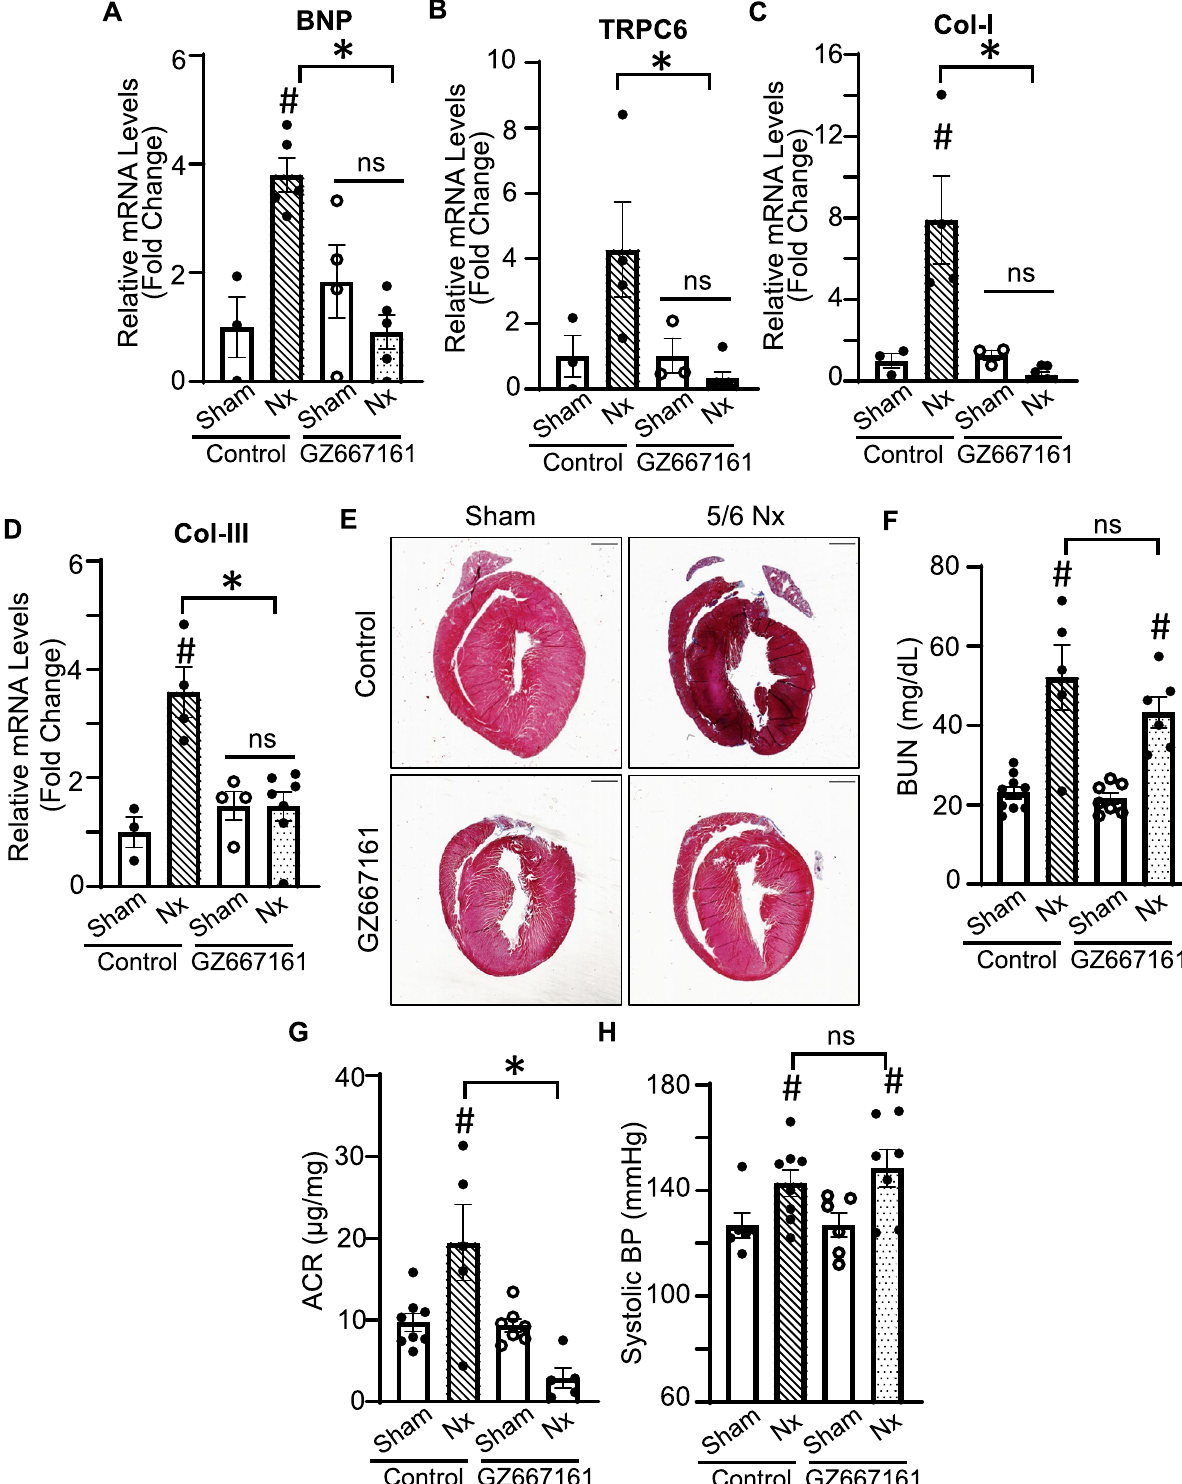
Figure 8. GZ667161 ameliorates expression of cardiac remodeling genes in CKD mice. ( A – D ) RNA from heart tissue was isolated and RT-qPCR was performed to examine the expression of cardiac remodeling genes in the heart in mice with 7 weeks post-5/6 Nx operation. ( A ) BNP. ( B ) TRPC6. ( C ) Col-I. ( D ) Col-III. ( E ) Representative trichrome staining of CKD hearts. Scale bar is 1 mm. Sham (n = 3–4 per group). CKD (n = 3–4 per group). GZ667161 compound does not impact or change physiological conditions of CKD. ( F ) Blood urea nitrogen levels. (n = 9,5 sham control, CKD control respectively) (n = 7,6 sham GZ667161, 5/6 Nx GZ667161, respectively). ( G ) Albumin creatinine ratio (ACR). ( H ) Systolic BP, 4 weeks post-operation shown. Sham (n = 6), 5/6 Nx (n = 7–8). # P < 0.05 Sham vs. 5/6 Nx in respective groups. # P < 0.05 vs. sham control of respective group. * P < 0.05 between indicated groups. ns, not significant between indicated groups. Data is expressed as mean ±